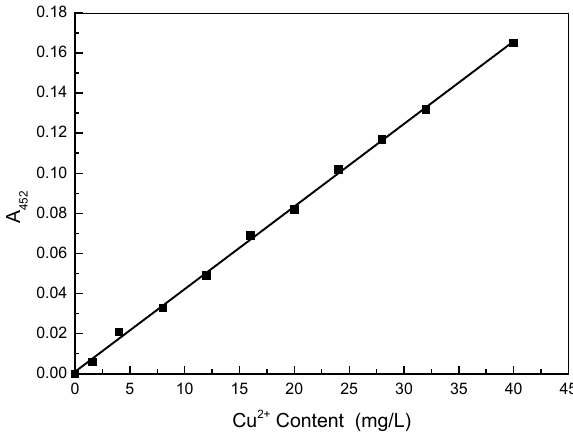
Figure 6: The calibration curve for copper ion